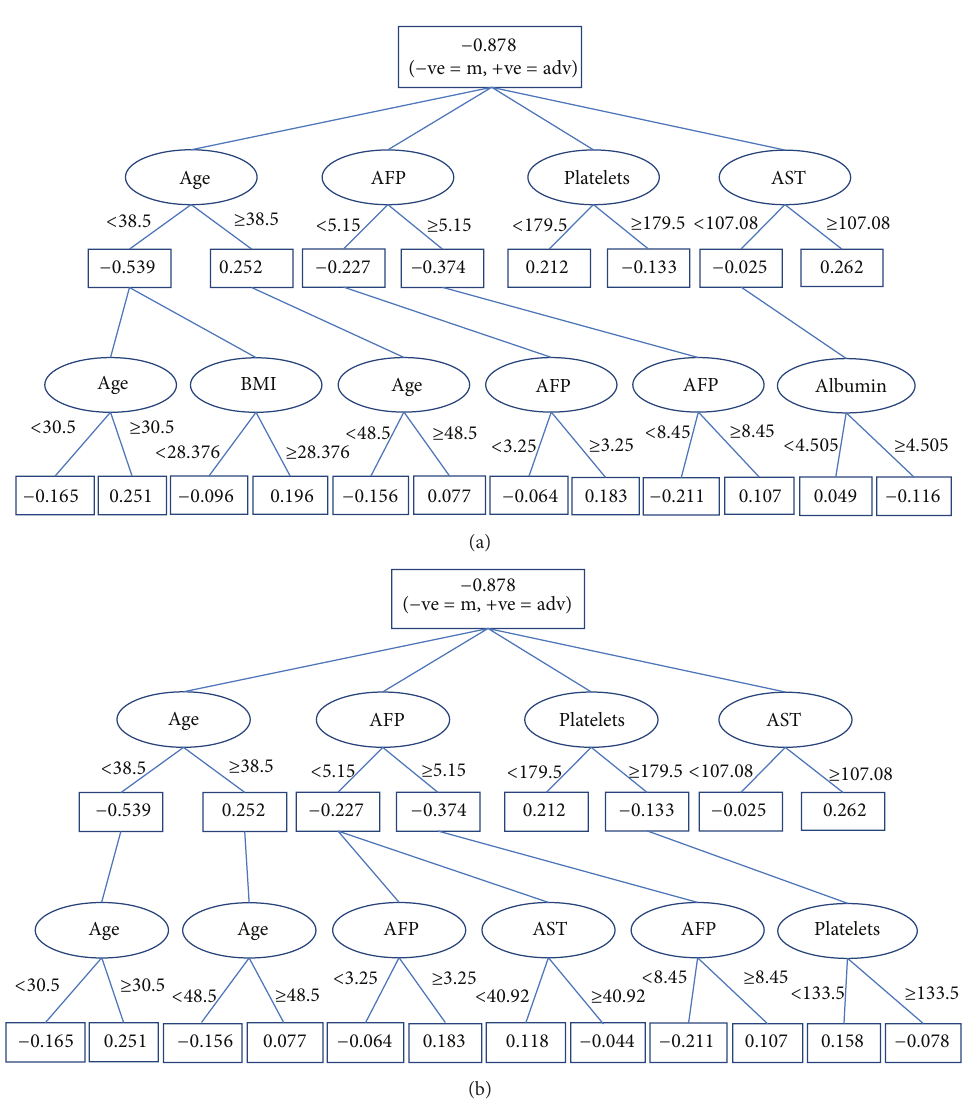
Figure 1: Decision tree diagrams. (a) Model 1. (b) Model 2. Advanced fibrosis is considered as the positive, referred to by symbol (adv), while moderate or mild fibrosis is considered as negative and referred to by symbol (m). The liver fibrosis of the patient is scored by summing all of the prediction nodes through which it passes.